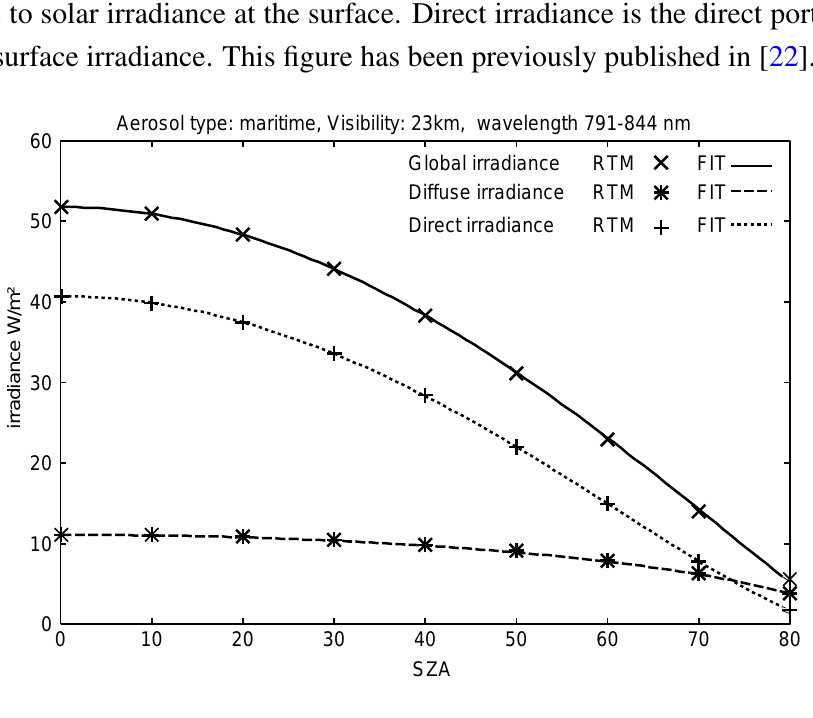
Figure 2. Comparison between RTM calculations and fit using the Modified Lambert–Beer